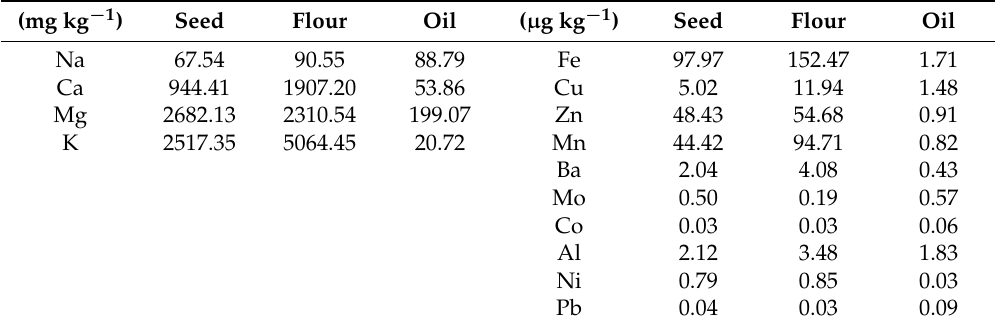
Table 3. Composition of macro and microelements of seed, flour, and oil of Fedora